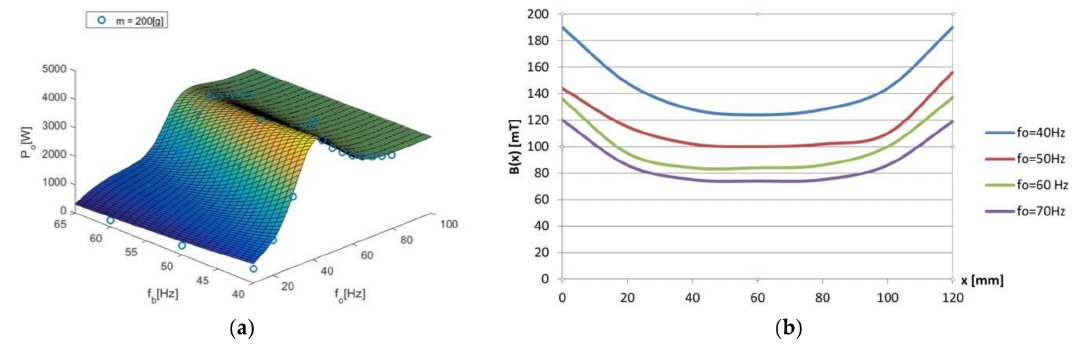
Figure 17. ( a ) Model of the active power dependence on output and basic frequencies for mill 100 mm of diameter and mass of grinding media 200 g; and, ( b ) distribution of the magnetic induction in the working chamber for the same mill with basic frequency equal 50 Hz.